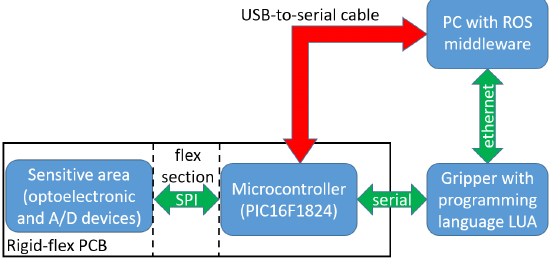
Figure 8. Data flow scheme of possible connections from the sensor to the control